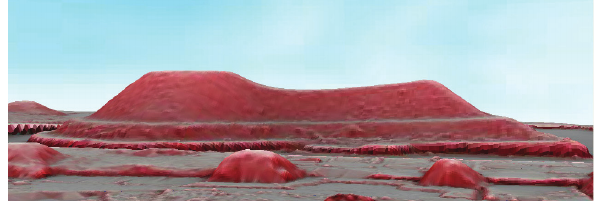
Fig 7. Konabe Mounded Tomb (Bird Eyes image on ground by Viewer)